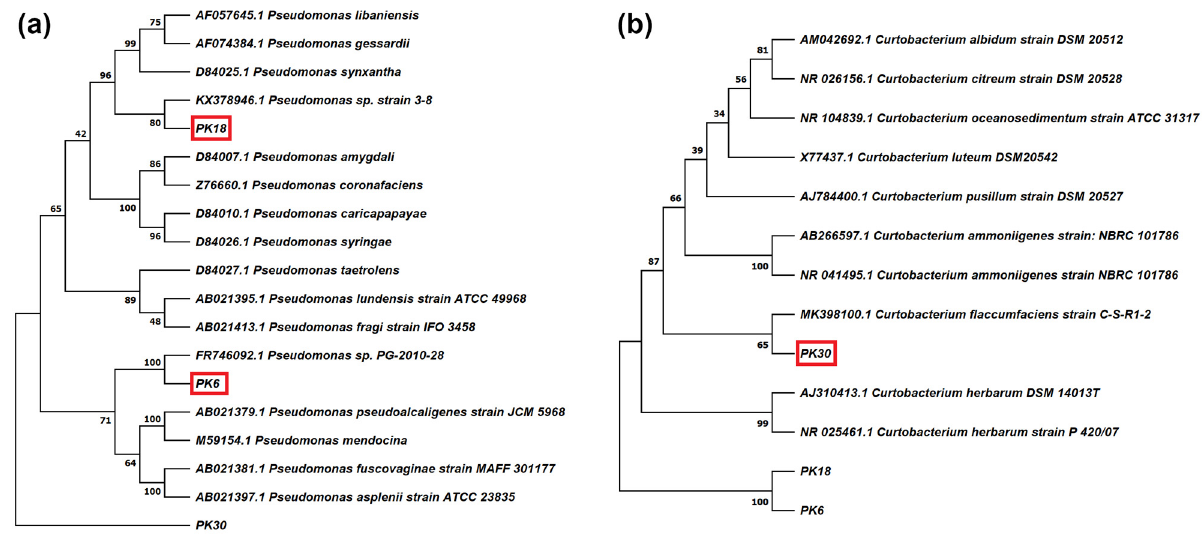
Figure 1. Phylogenetic tree based on 16S rRNA gene sequences of ( a ) PK6 and PK18 strains identified as Pseudomonas spp. and ( b ) PK30, identified as Curtobacterium sp. PK30 was used as outgroup for building the Pseudomonas tree, and PK6 and PK18 were used as outgroup for building the Curtobacterium tree.